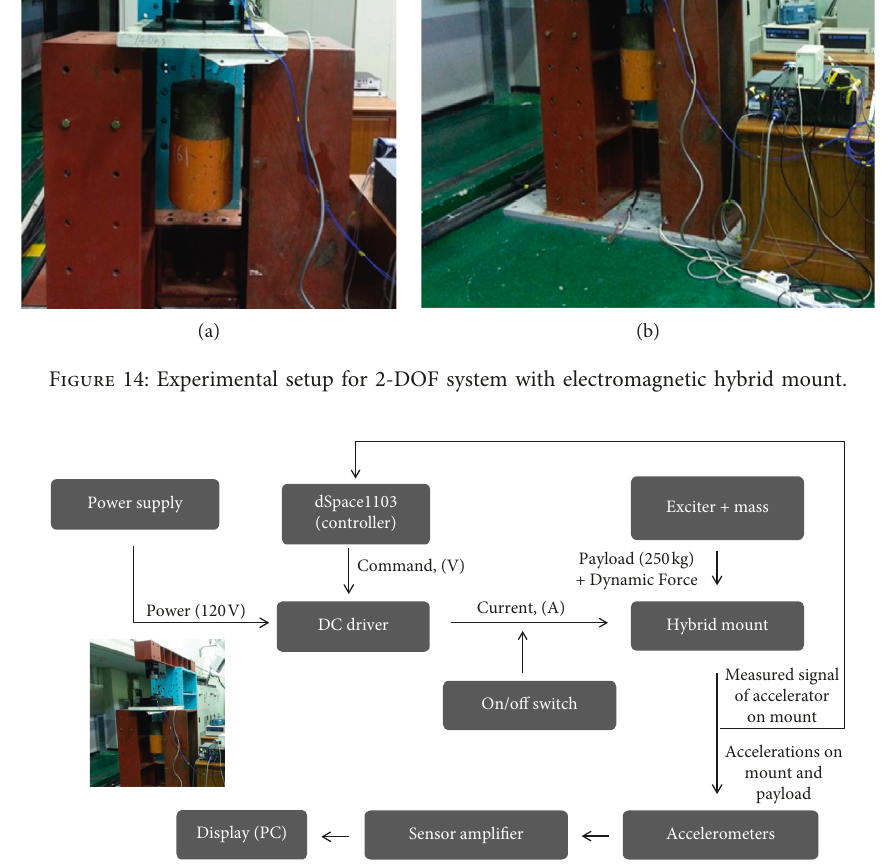
Figure 15: Schematic diagram for 2-DOF system with electromagnetic hybrid